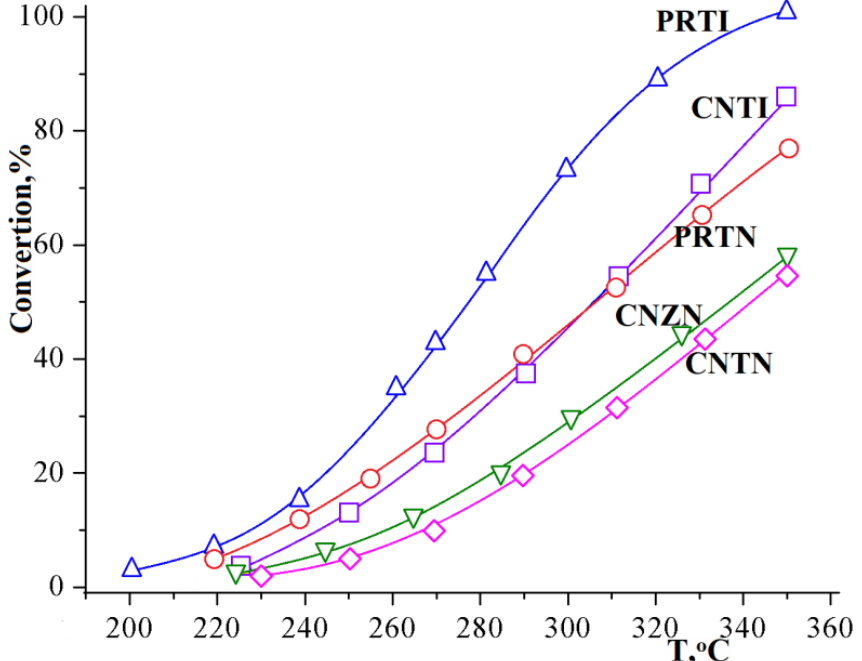
Figure 5. Temperature dependence of methanol conversion using various catalysts.